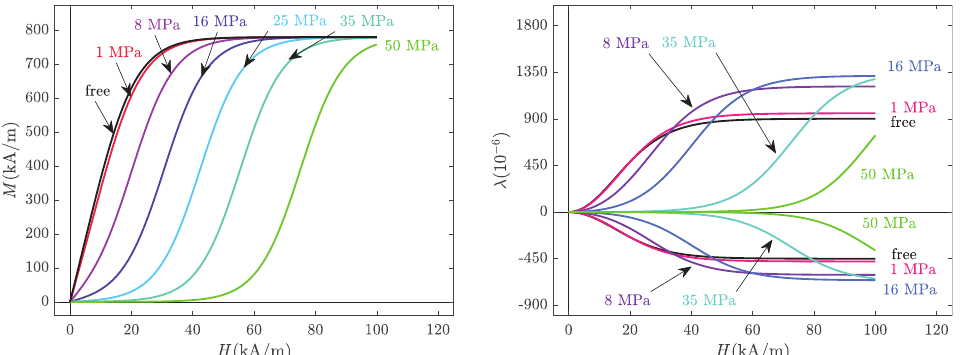
Figure 5. Anhysteretic magneto-elastic behaviour: magnetisation ( left ) and magnetostriction strain ( right ) at various levels of compressive stress. Modelling results from analytical